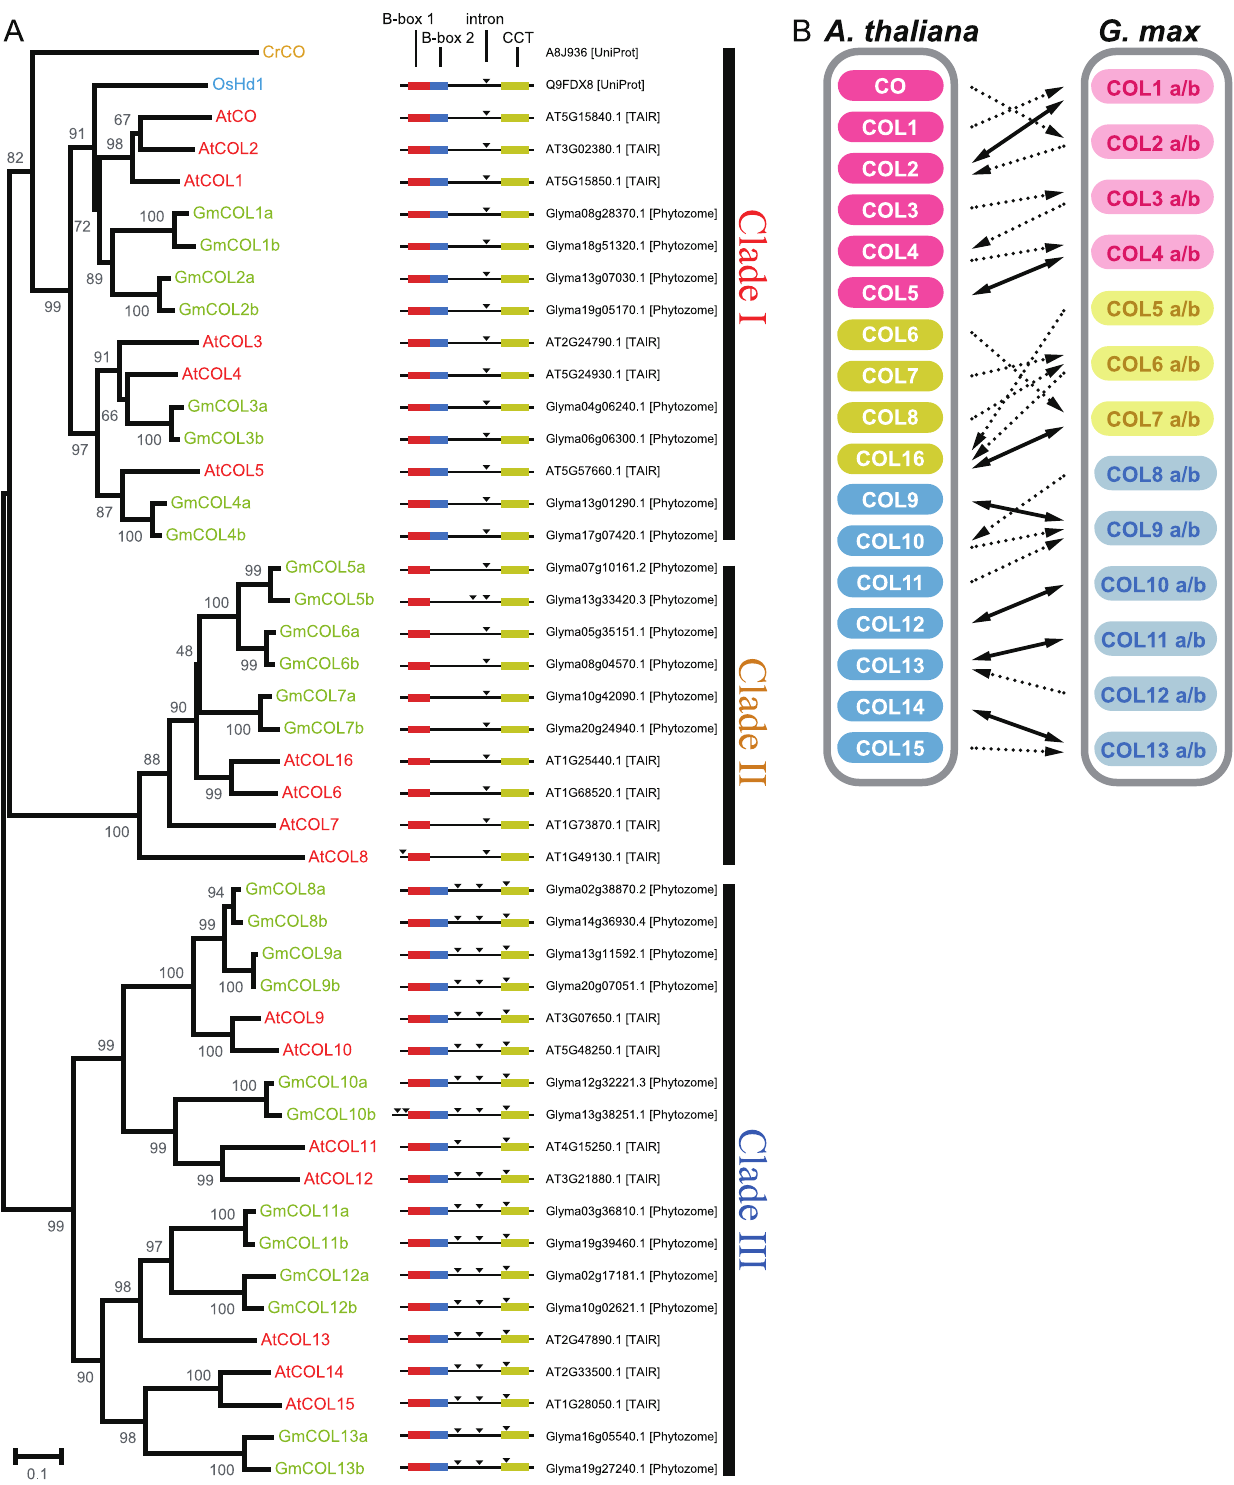
PLOS ONE | www.plosone.org 4 January 2014 | Volume 9 | Issue 1 |